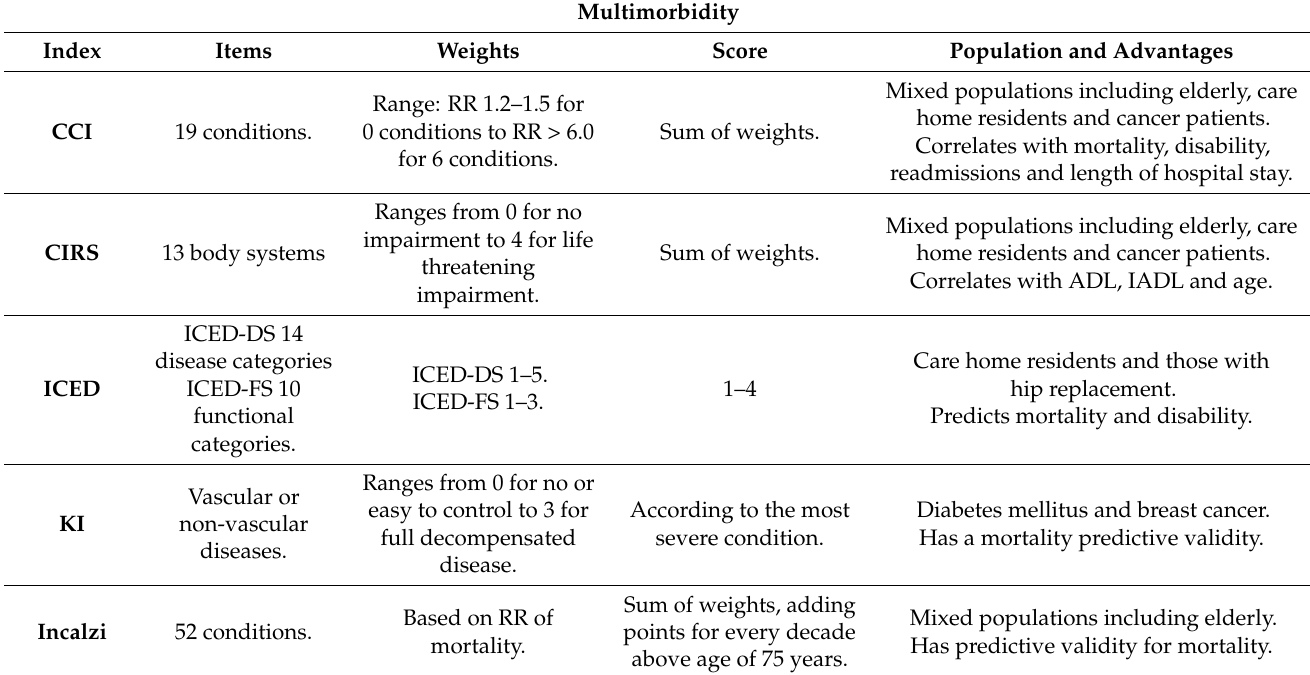
Table 1. Commonly used multimorbidity and frailty assessment indexes and tools.